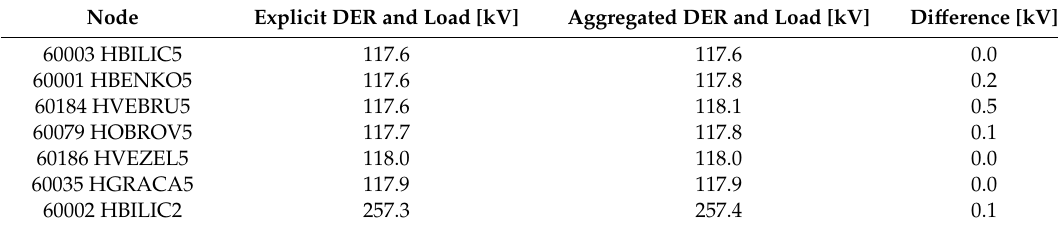
Table 6. Node voltage comparison [kV].